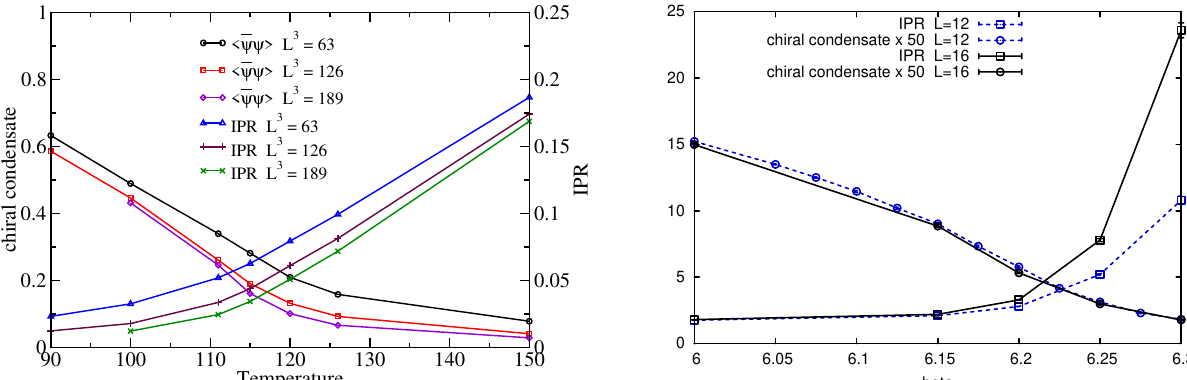
Figure 7. Left : IPR of the lowest Dirac mode and chiral condensate in an ILM model for QCD with two massless fermions for various system sizes (in fm 3 ). From Ref. [27]. (Reprinted from Nucl. Phys. A, 770, A.M. García-García and J.C. Osborn, “Chiral phase transition and Anderson localization in the Instanton Liquid Model for QCD”, Pages 141–161, Copyright (2006), with permission from Elsevier). Right : IPR (here times the volume V = L 3 ) of the low Dirac modes and chiral condensate in 2+1 flavor QCD with staggered fermions. From Ref. [28]. (Reprinted figure with permission from A.M. García-García